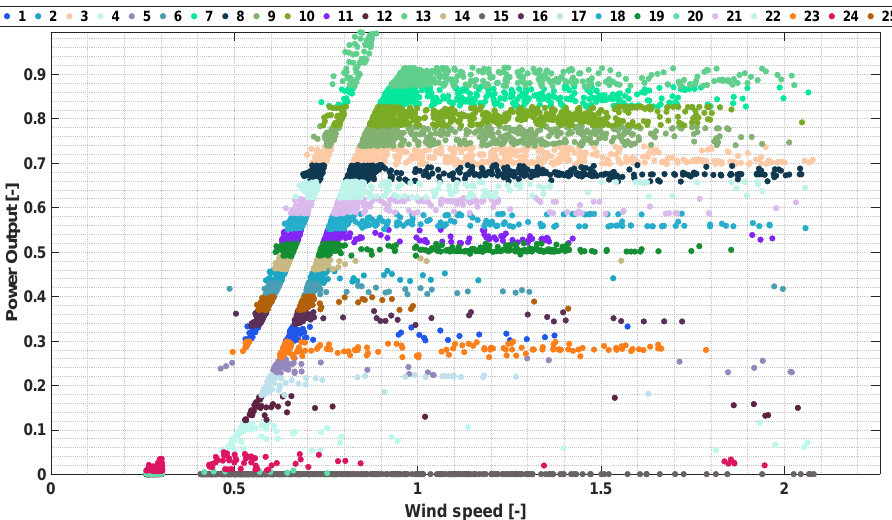
Figure 4. The Invalid Data Partitioning where the optimal number of classes computed is